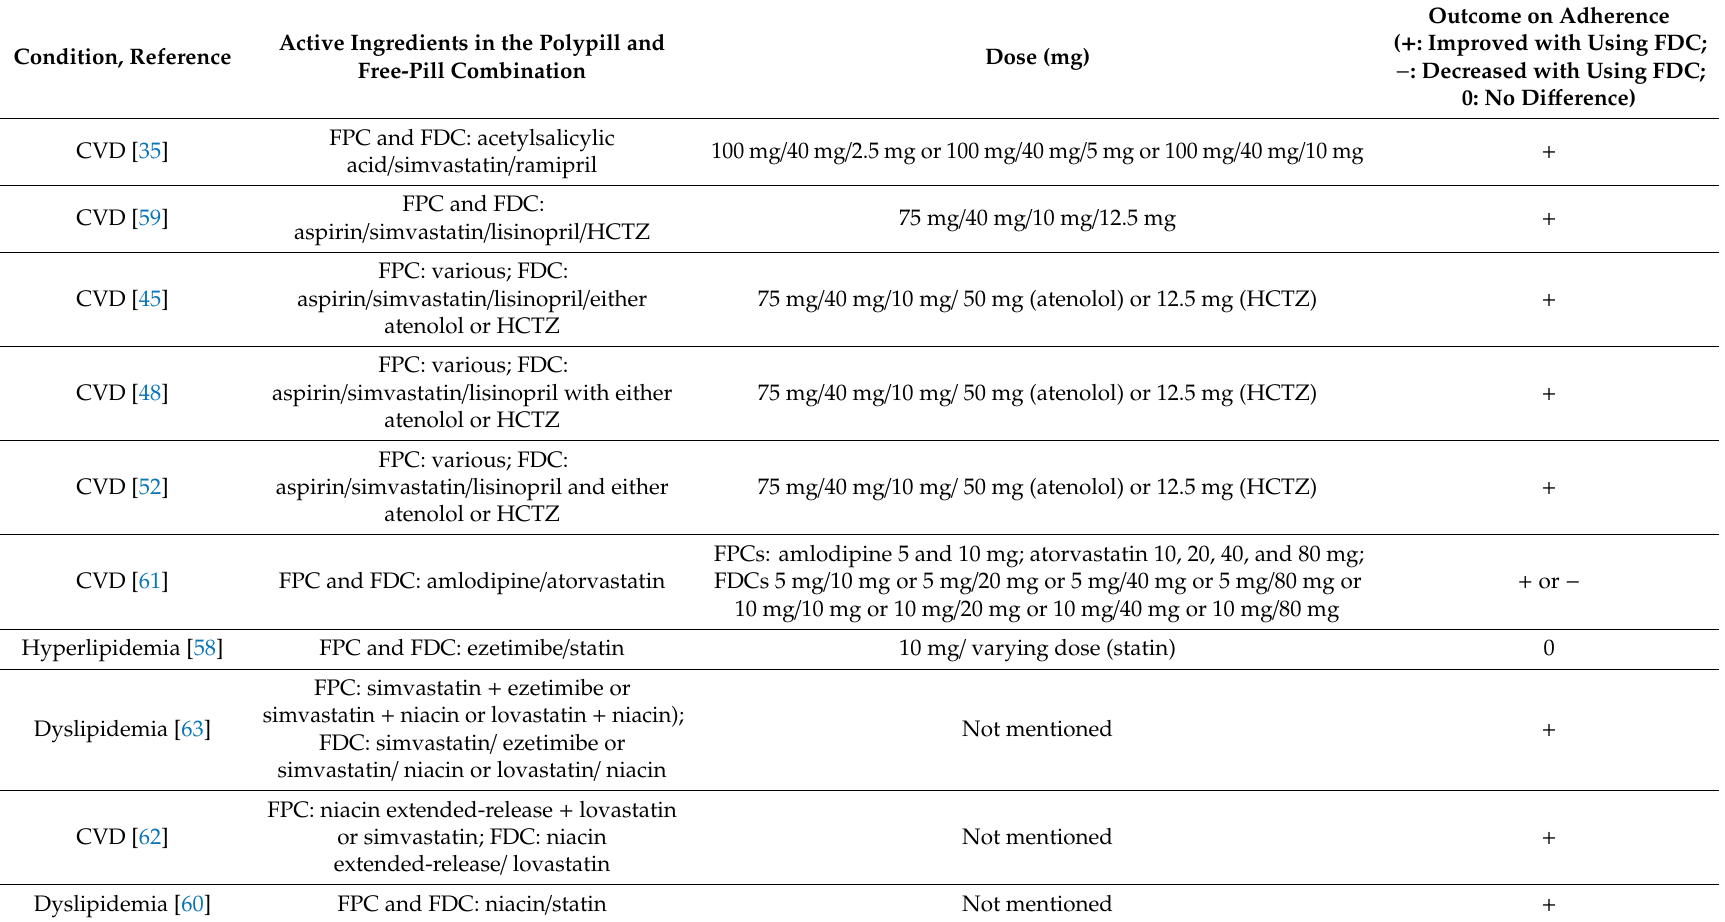
Table A3. General article information regarding disease, drugs, formulation, and